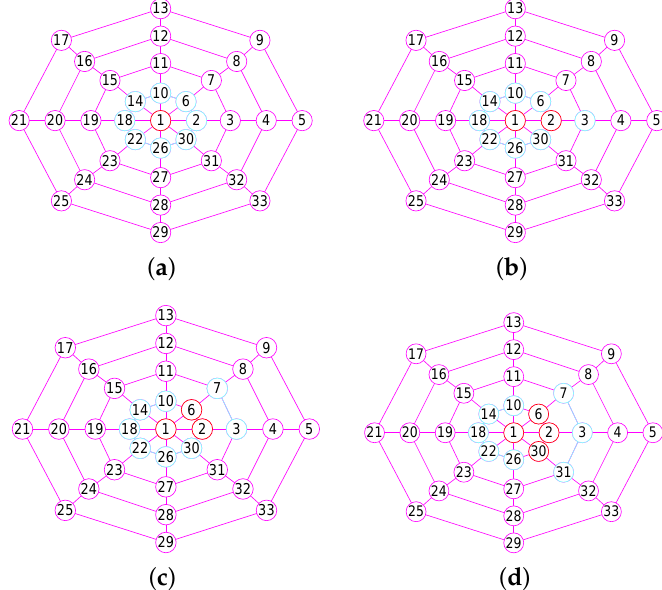
Figure 3. The 1-neighborhood subgraphs for the different nodes sets of a wheel graph G . ( a ) A wheel graph G and the 1-neighborhood subgraph N ( 1 ) of the node 1; ( b ) The 1-neighborhood subgraph N ( S 1